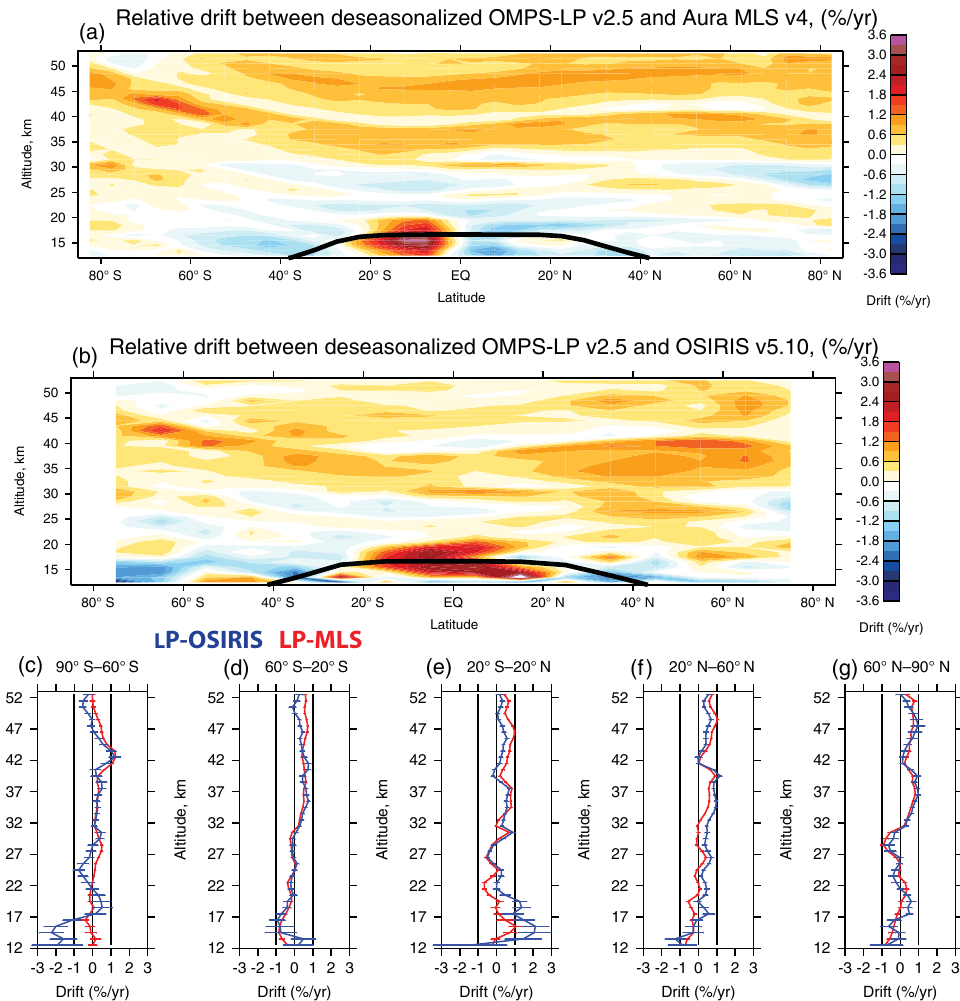
Figure 16. Relative drift for OMPS LP version 2.5 against Aura MLS and Odin OSIRIS. Panel (a) shows the relative drift between OMPS LP and MLS as a function of latitude and altitude (on 5 ◦ latitude grid). Panel (b) illustrates relative drift between OMPS LP and OSIRIS (on 10 ◦ latitude grid). Panels (c–g) show vertical structures of the drift in five wide latitude bins against MLS (red lines) and OSIRIS (blue lines). Error bars show 1 σ standard deviations for the linear